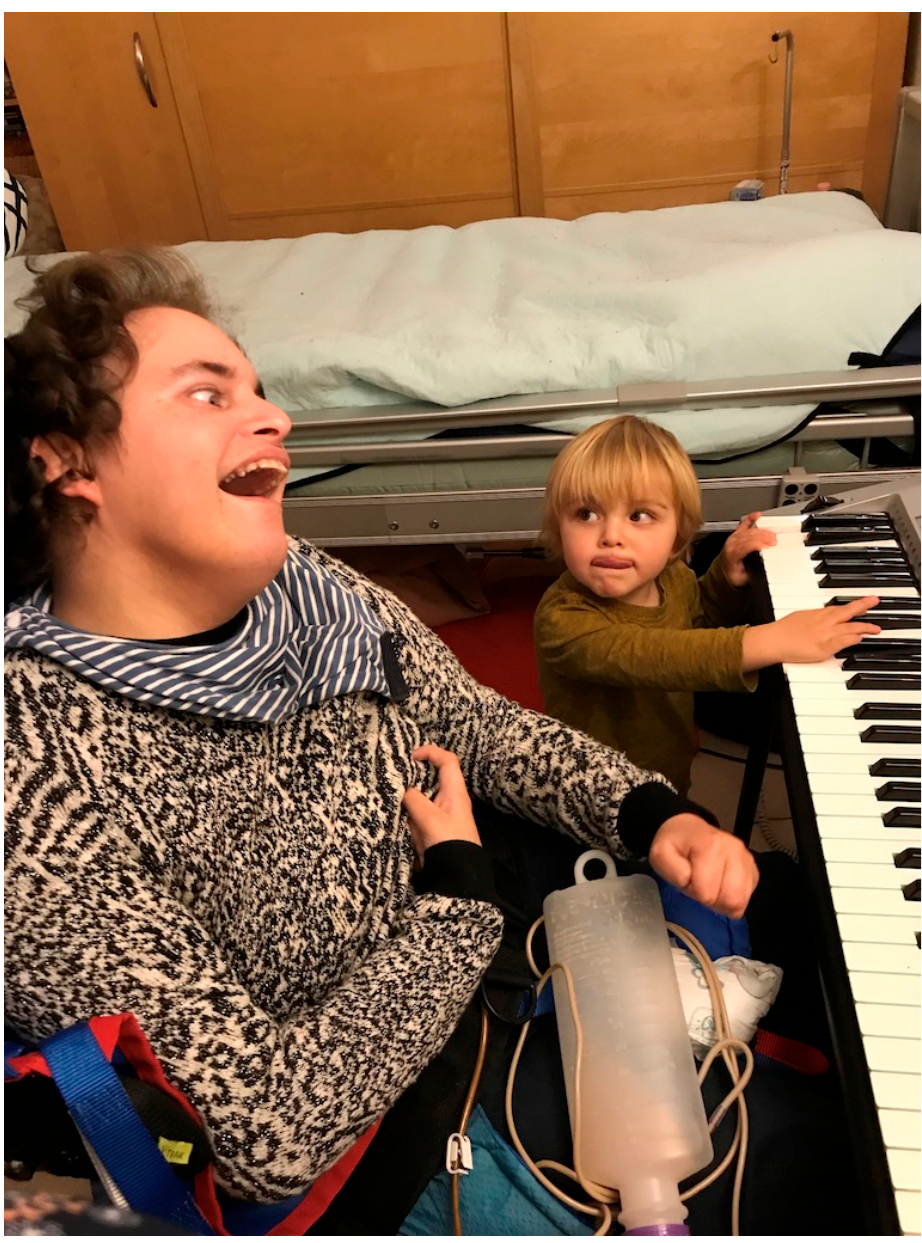
Figure 2. Johanna, the daughter of one of the authors (Catherine), enjoyed playing with her